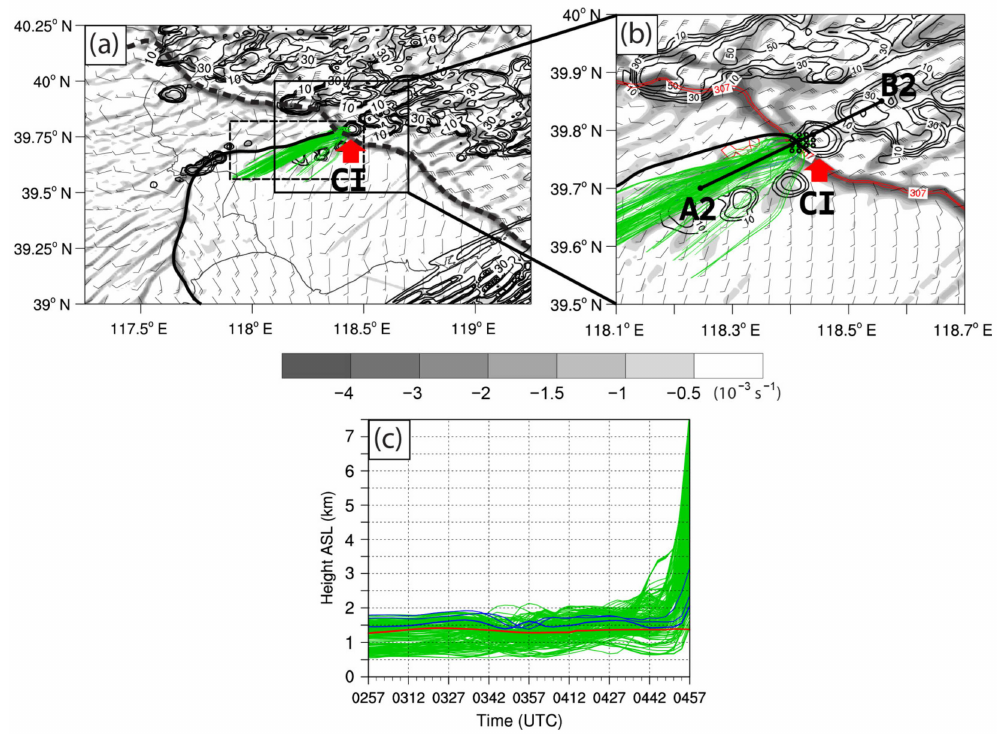
Figure 10. ( a ) Simulated horizontal divergence (shading, units: 10 − 3 s − 1 ), composite reflectivity (black contours, units: dBZ, with 10 dBZ intervals), wind field (full and half barbs represent 4 and 2 m s − 1 , respectively) at 10 m (AGL), ground-relative backward trajectories (green and blue lines, projected to the ground) of air parcels for 2 h within the selected convective cell (indicated by red arrow) at 0457 UTC on 31 July 2010. The black solid and dashed lines indicate the locations of the SBF and GF, respectively. The black dashed rectangle area shows the area for calculating the area-mean planetary boundary level height (PBLH) shown in ( c ); ( b ) is the magnified area of the black sold rectangle area in ( a ). It also shows the potential temperature (red solid contours at values of 306 and 307 K) that indicates the thermal boundary of the GF. The line segment A2B2 shows the location of the vertical cross section that well be shown in Figures 12–14; ( c ) Height along the backward trajectories of air parcels with vertical velocities in the top 25% quantile at the CI time within the selected convective cell. For parcels higher (lower) than PBLH in the 2 h period, they are colored in blue (green). The height of the PBLH is in